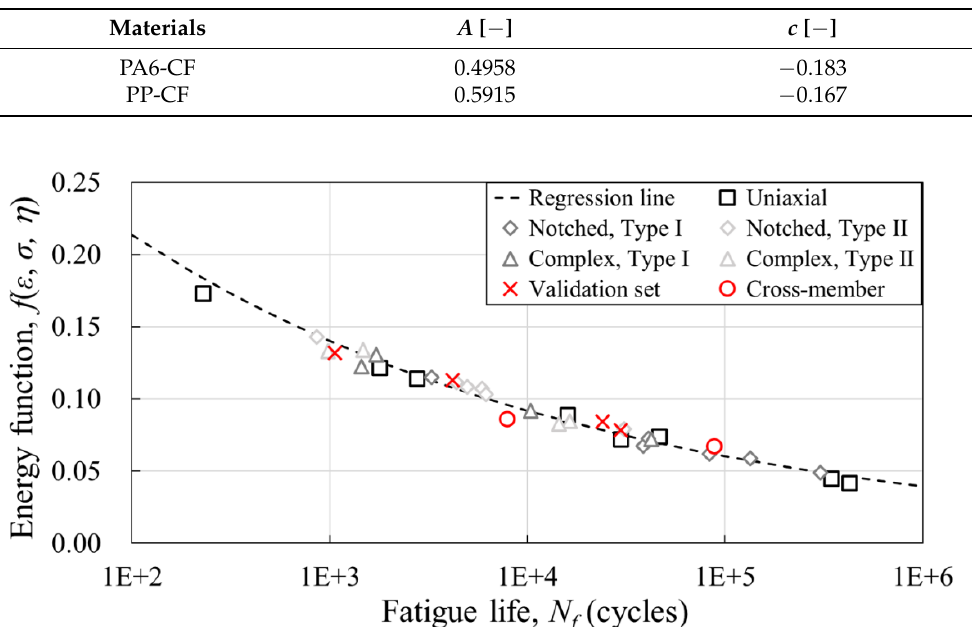
Figure 18. Energy function vs. fatigue life graph with regression line of the PP-CF (log-linear scale). 4. Discussion To develop a fatigue life prediction model for short CFRP, experimental and numer- ical analyses of PA6-CF and PP-CF were conducted. Anisotropy and exposure to complex stress state significantly affected CFRP’s static and cyclic mechanical properties. In partic- ular, it was found that when a load was applied in a direction consistent with the fiber arrangement, the tensile strength significantly increased. In addition, higher triaxiality re- sulted in a more complicated fracture pattern and shorter fatigue life, making it difficult to predict the life of injection molded CFRPs. This study employed a triaxiality range of 0.333 to 0.655 to investigate the multi-axial stress state. Furthermore, it was confirmed that the triaxiality was higher when the load was applied in the opposite direction to the fiber arrangement with the same geometry specimen. The effect of anisotropy caused by fiber orientation can be explained through the ex- perimental results of the directionally machined specimens. In the case of static tests, the